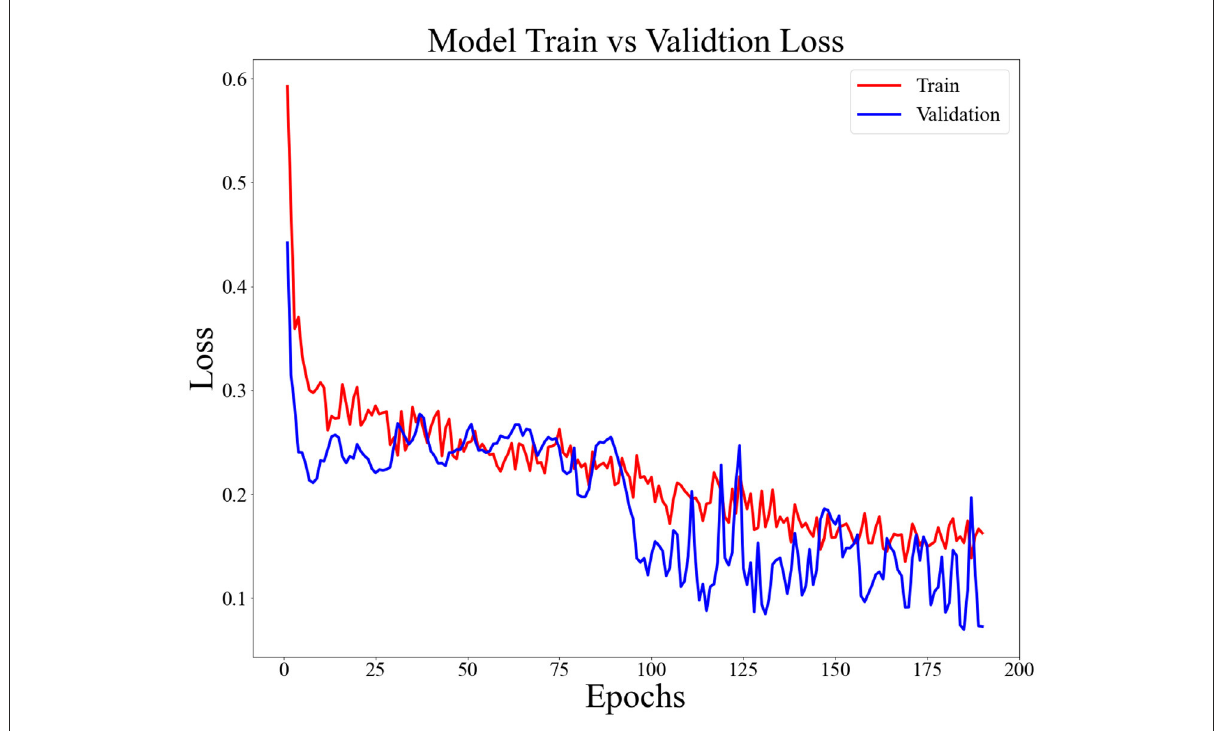
FIGURE6 Loss function for LSTM